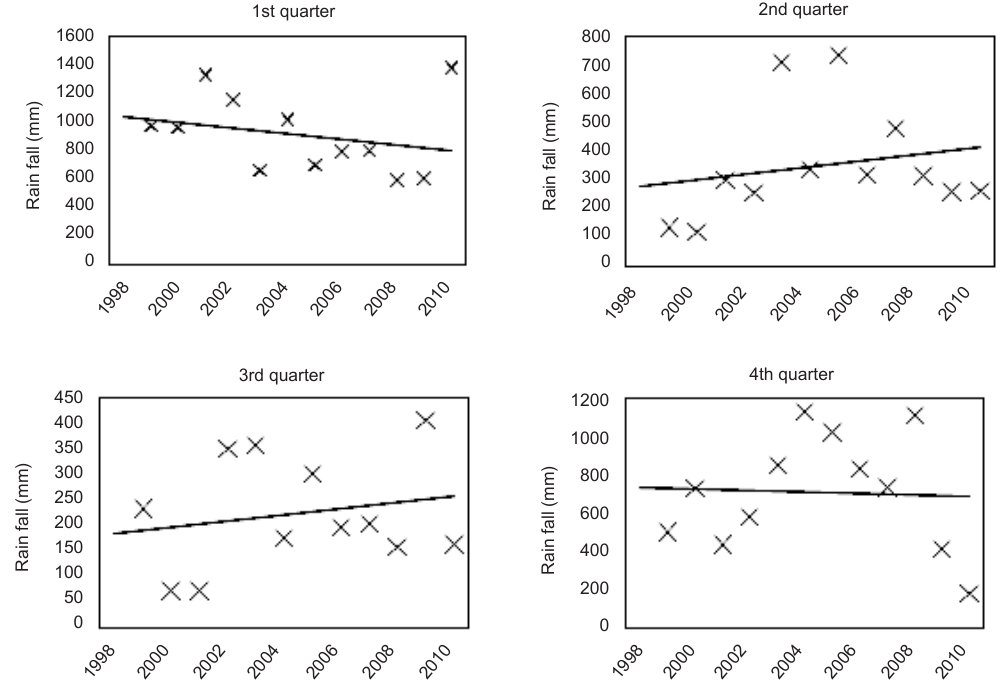
Figure 3. Quarterly rainfall changes at La Passe in